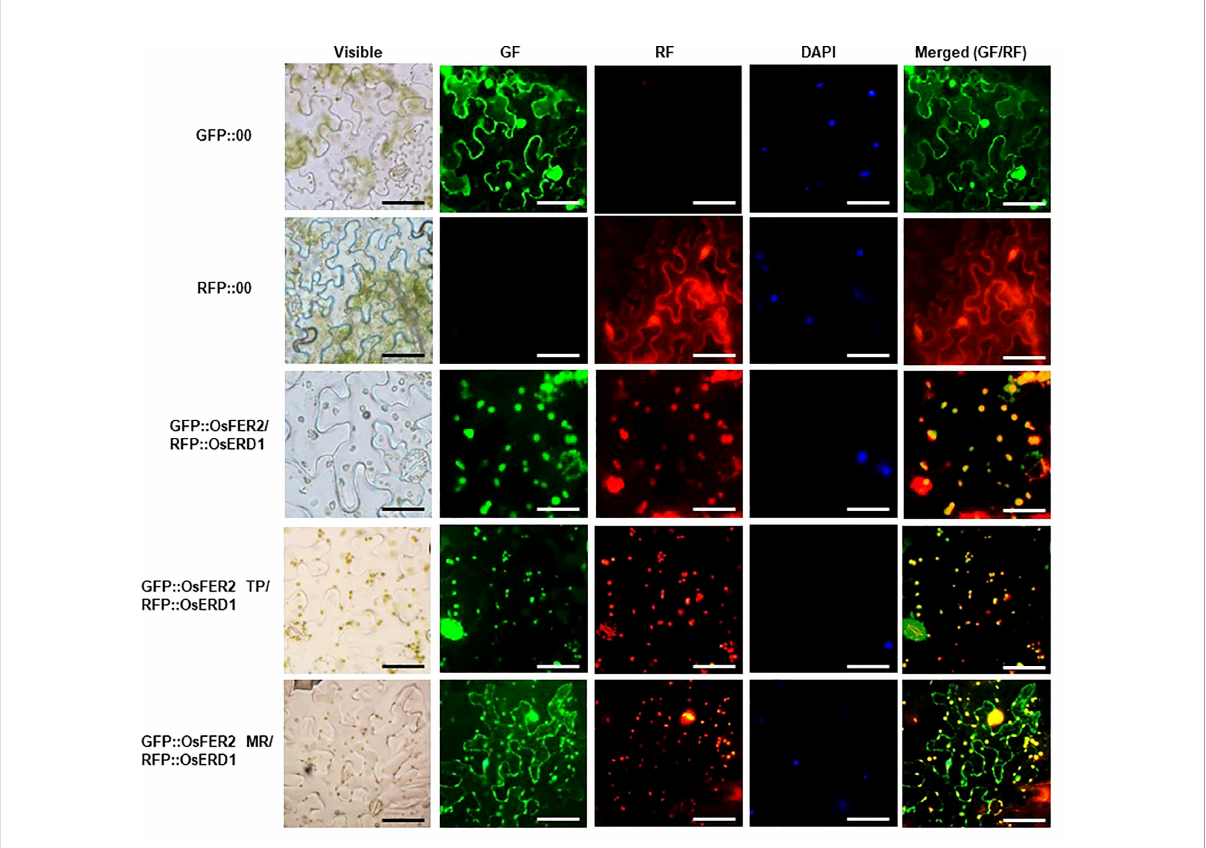
FIGURE 2 Subcellular localization of OsFER2 and its domains at 48 h after agroin fi ltration into Nicotiana benthamiana leaves. 4 ’ ,6-diamidino-2- phenylindole (DAPI) staining was used to visualize nuclei in N. benthamiana epidermal cells. RFP::OsERD2 was used as a chloroplast marker. Images were taken with a fl uorescence microscope using bright fi eld (visible), GF (green fl uorescence), RF (red fl uorescence) and DAPI fi lters. GFP, green fl uorescent protein; RFP, red fl uorescent protein; TP, transit peptide; MR, mature region. Scale bar=50